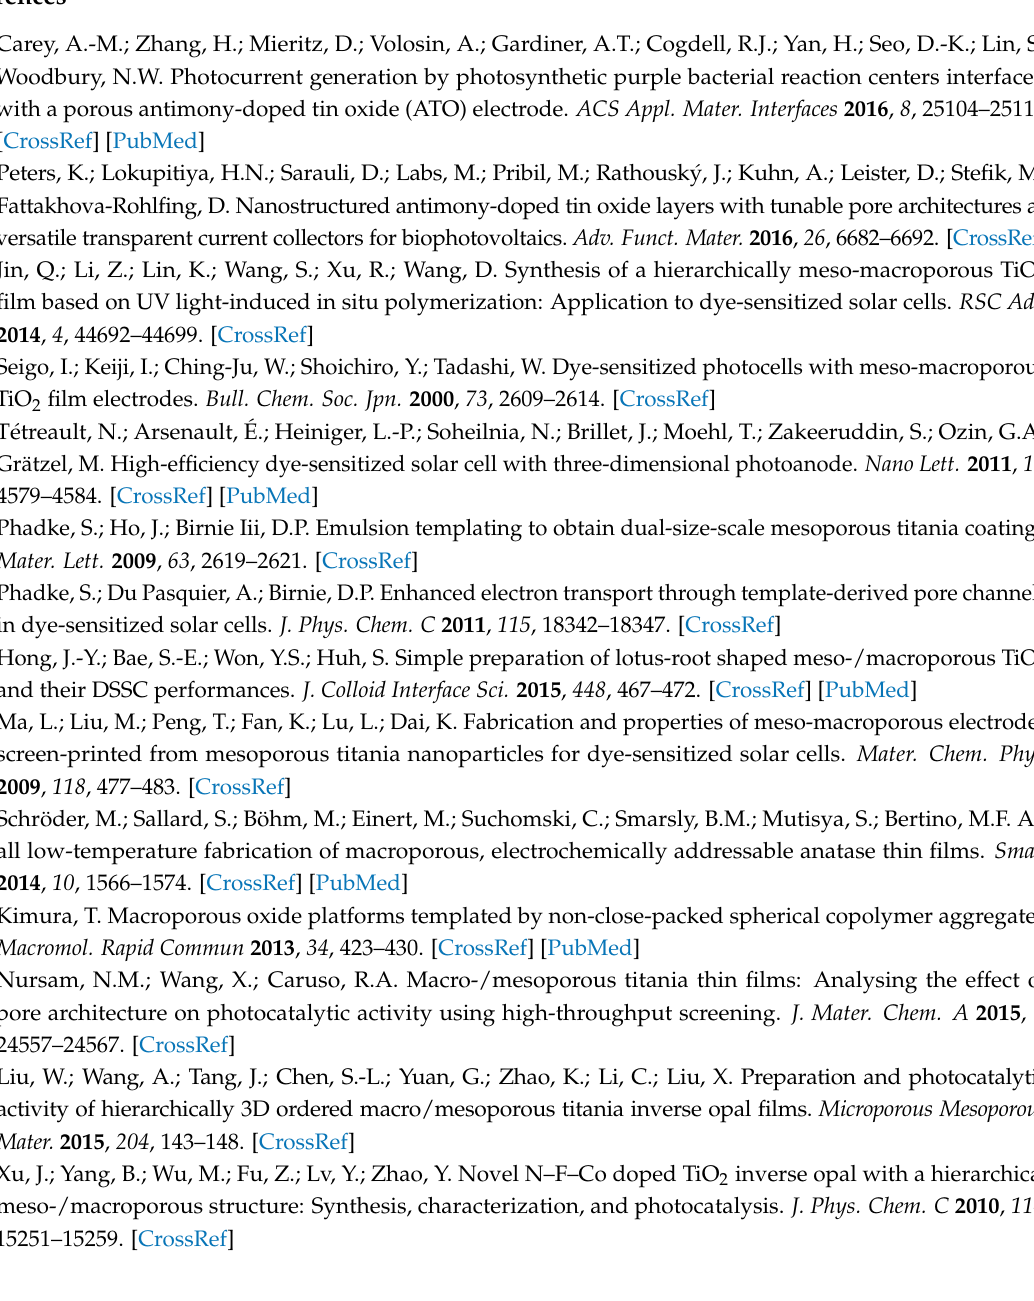
Figure S7: Photograph of 2 × thick CB5–PEG10–ATO coatings on FTO glass, and onto the left coating has been dropped enough water to saturate the coating, Table S1: Precursor amounts to produce mixtures for viscosity measurement, and reaction mixtures for ATO coating